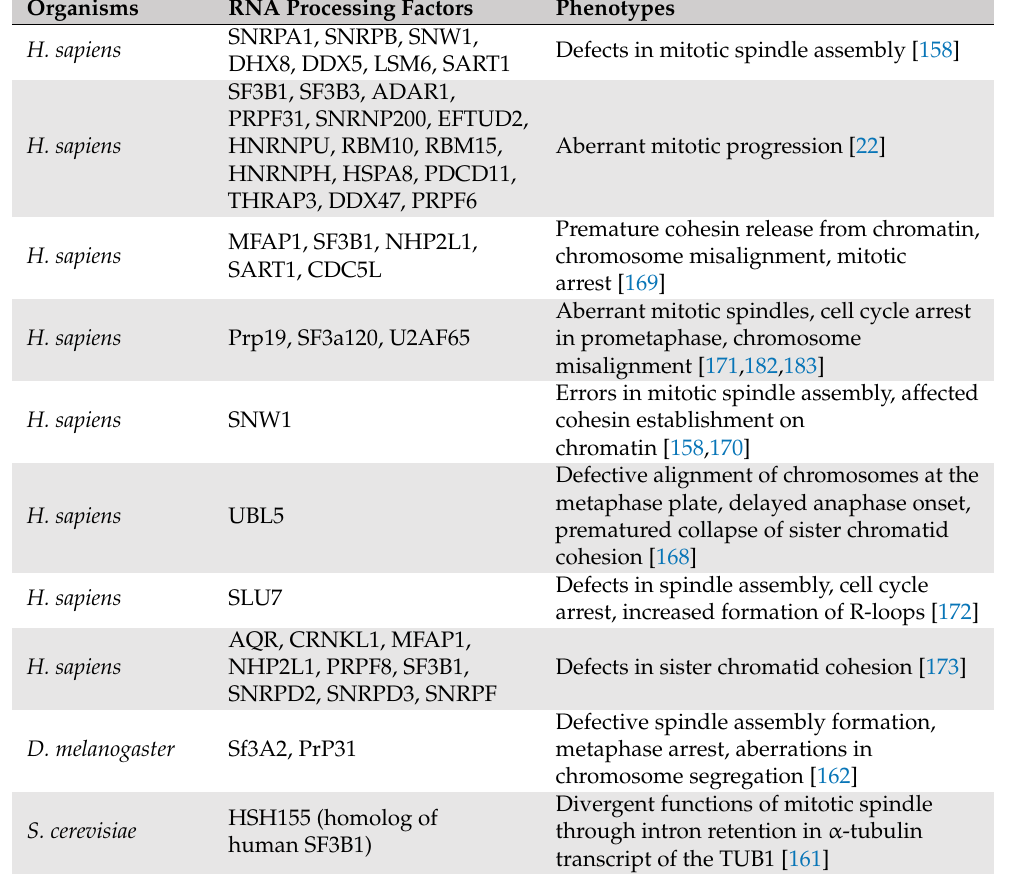
Table 2. Summary of RNA processing factors whose deregulation affects fidelity of chromosome segregation and genome